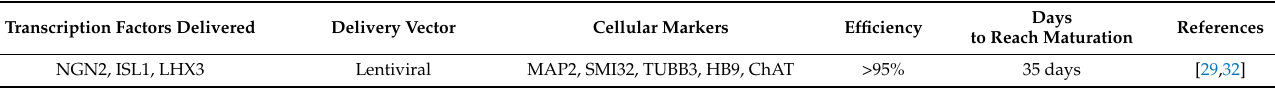
Table 6. Transcription factors used in generation of